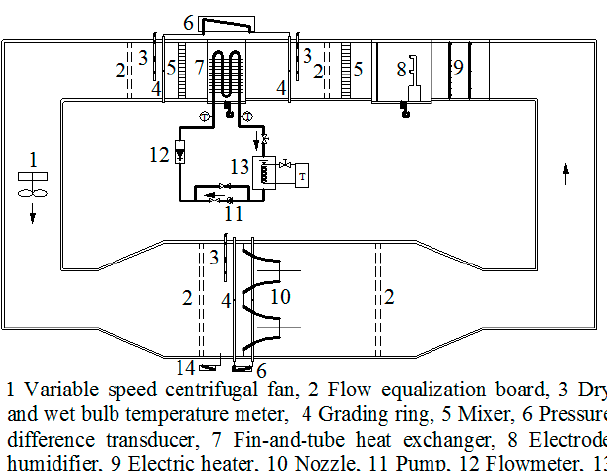
Figure 1. Schematic diagram of the experimental system.